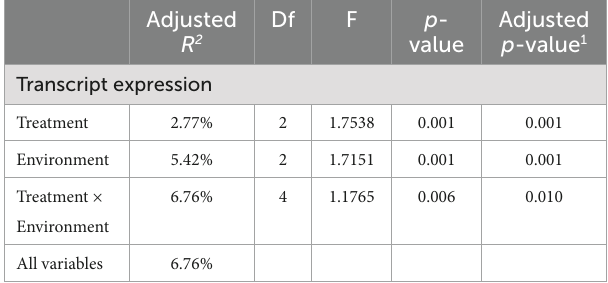
Models were constructed using the forward selection process, maximizing the adjusted R 2 and p -value (ordiR2step function from the R package vegan). Genetic variation among origins and its interaction with treatments were also included in the initial model, but were not selected, and therefore not included in the table. 1 p -value were adjusted following Holm’s correction for multiple